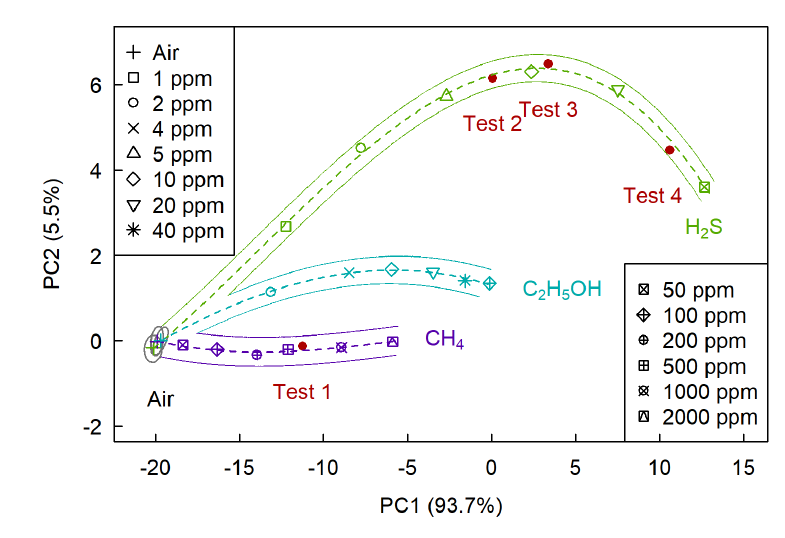
Figure 11. The (PC1, PC2) plane at the determination of H 2 , CH 4 , and C 2 H 5